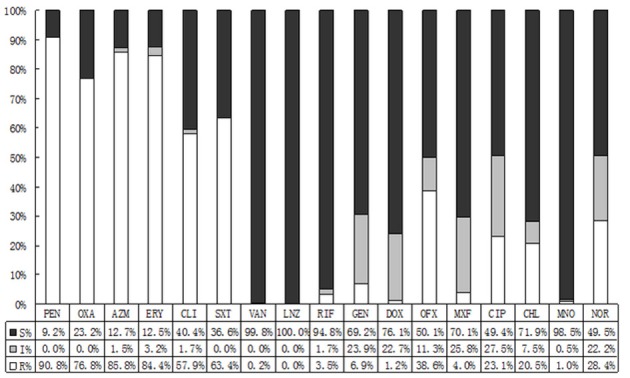
The antibiotic resistance patterns of coagulase-negative Staphylococcus (CONS) strains. S, Sensitive; I, Intermediate; R, Resistant; PEN, Penicillin; OXA, Oxacillin; AZM, Azithromycin; ERY, Erythromycin; CLI, Clindamycin; SXT, Trimethoprim-Sulfamethoxazole; VAN, Vancomycin; LNZ, Linezolide; RIF, Rifampicin; GEN, Gentamycin; DOX, Doxycycline; OFX, Ofloxacin; MXF, Moxifloxacin; CIP, Ciprofloxacin.